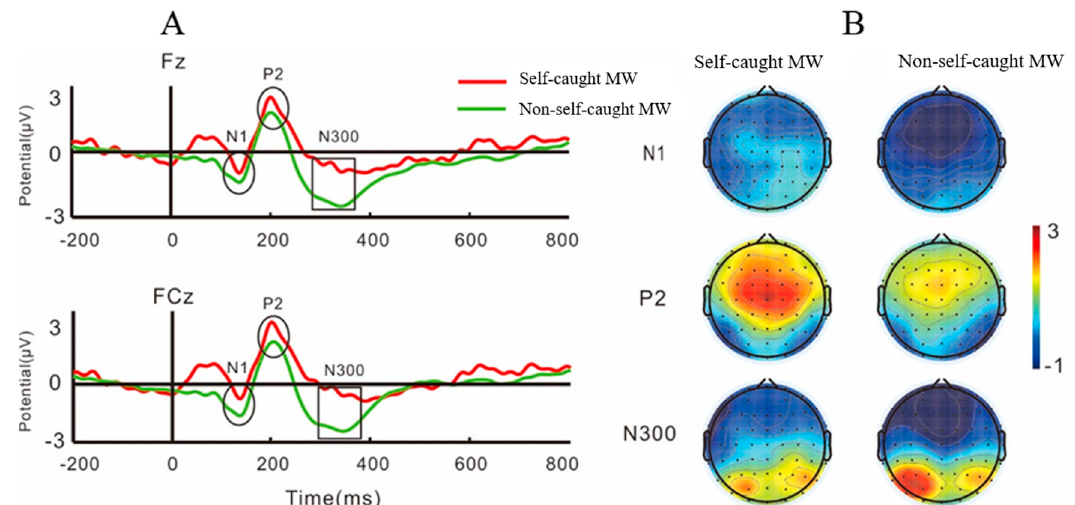
Figure 2. The mean amplitudes of N1, P2 and N300 ( A ) and topography plots ( B ) during self-caught MW and non-self- caught MW.